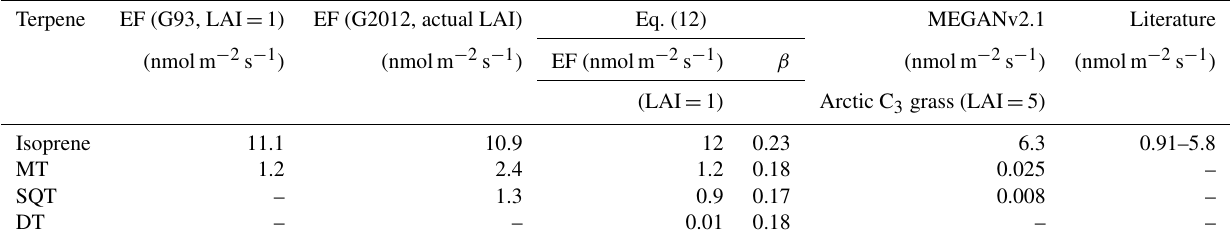
Arctic C 3 grass (LAI = 5)